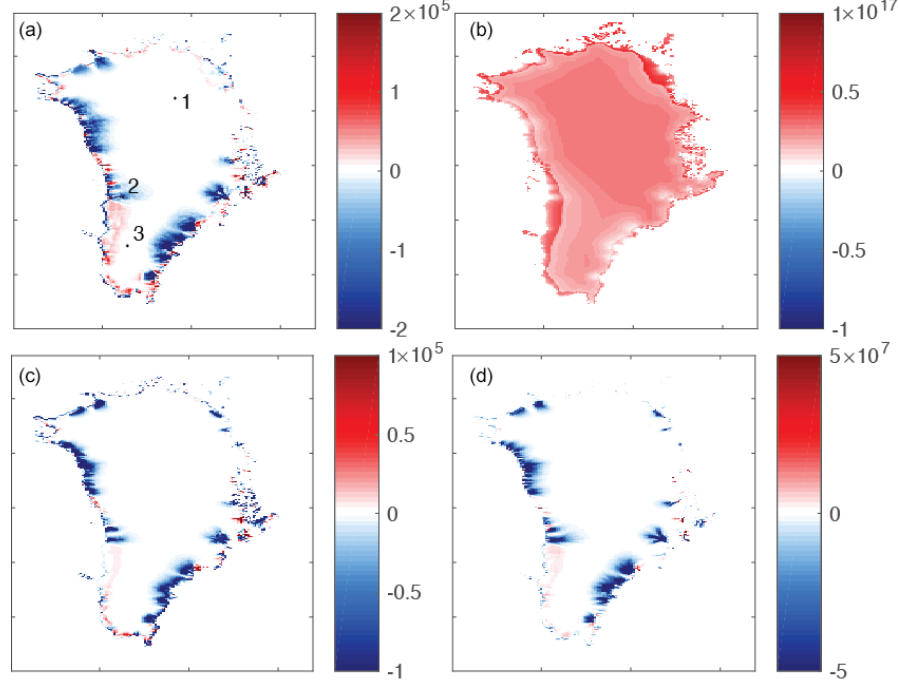
Figure A1. Adjoint sensitivities, δJ , for the Greenland Ice Sheet, where i is the control variable shown. Control variables are the (a) initial δX i ice thickness (m 2 ), (b) mean July precipitation (m 2 yr), (c) surface temperature (m 3 ◦ C − 1 ), and (d) basal temperature (m 3 ◦ C − 1 ). Locations in (a) numbered 1–3 are compared to finite-difference values in Table